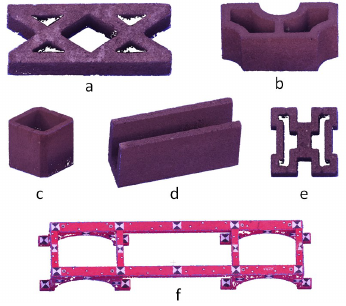
Figure 4. Comparison of 3D point clouds from Lumix and GoPro camera systems of calibration scene in air.